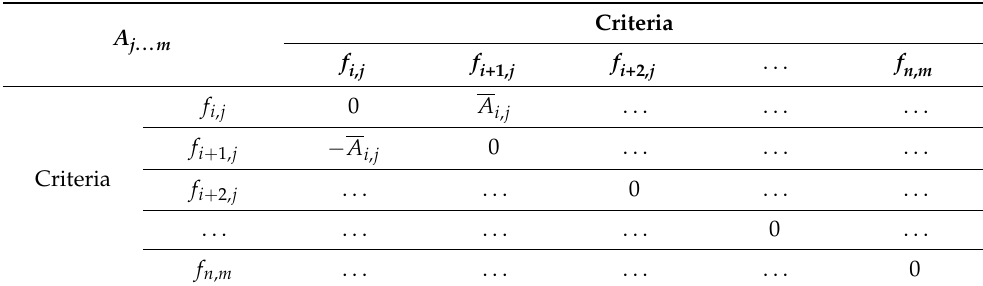
Table 4. A module matrix of transformations of the differences of the average distance from the maximum value between the websites for each